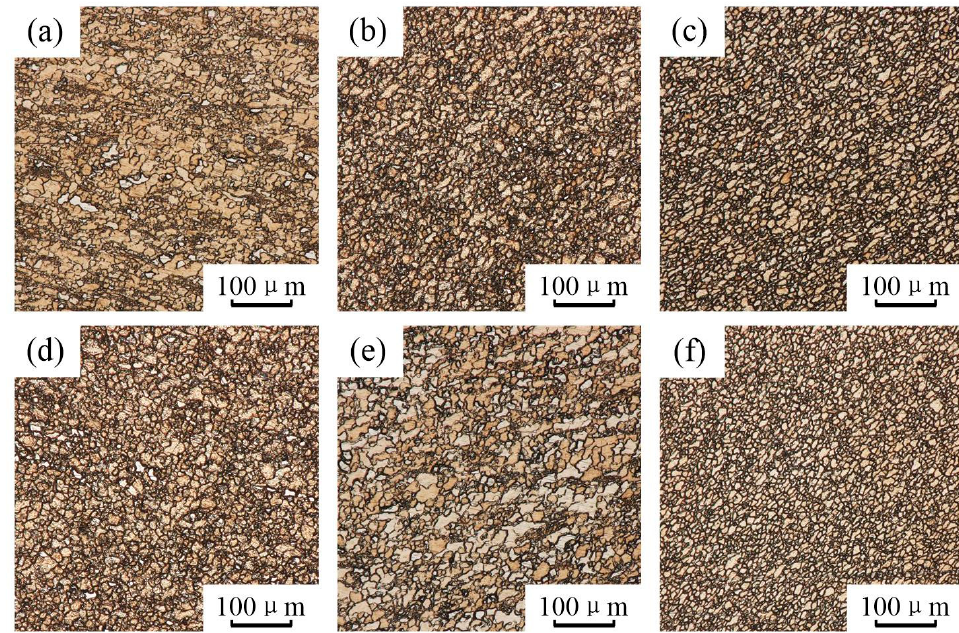
Figure 6. Optical micrographs in various stirring sub-zones of the two welded joints:( a ) SZ1, ( b ) SZ2, ( c ) SZ3 of the ZK60/ATZ511 joint; ( d ) SZ1, ( e ) SZ2, ( f ) SZ3 of the ATZ511/ZK60 joint.